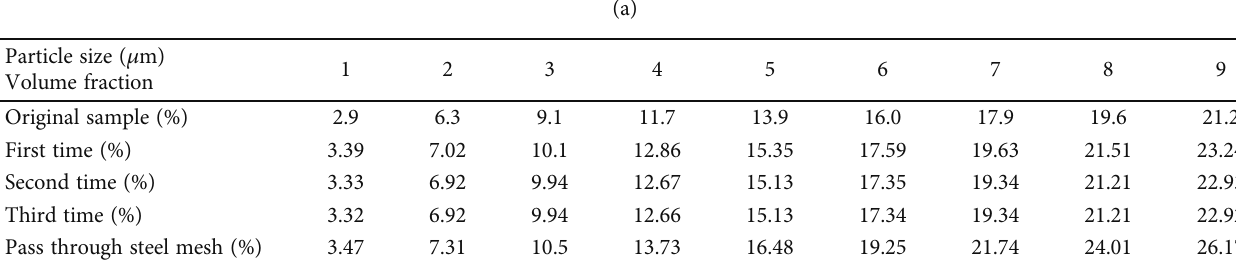
Table 6: Volume fraction of tailing sand under steel